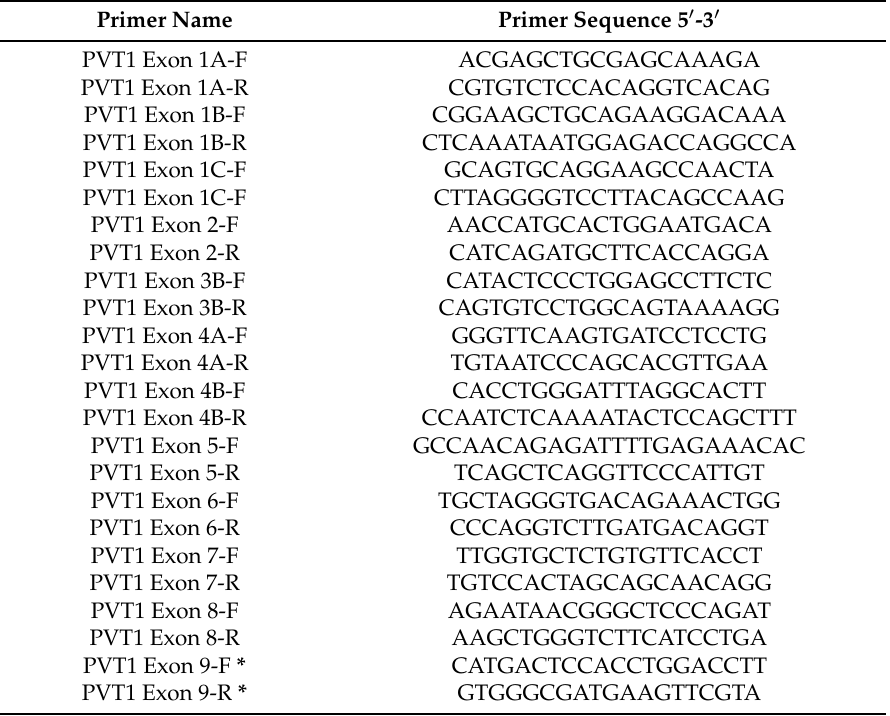
Table 2. List of primer sequences of PVT1 exons; * patent